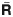
Undirected Graph from R¯.